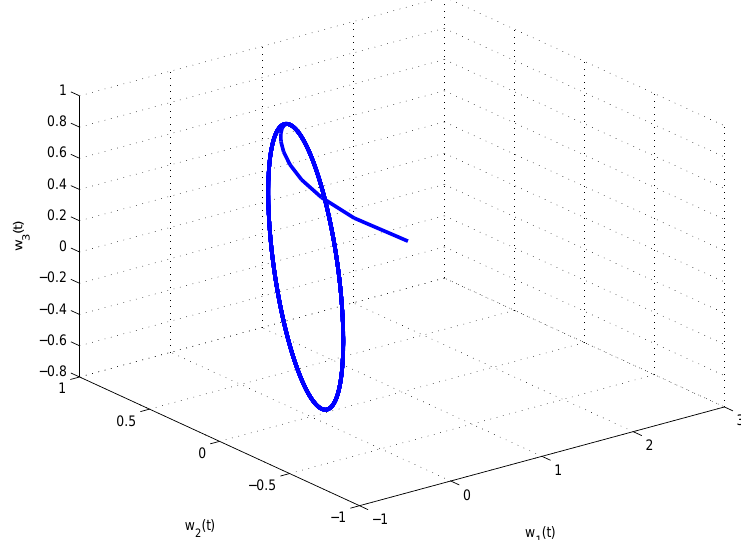
Figure 4. The phase trajectories of w 1 ( t ) , w 2 ( t ) and w 3 ( t ) of system (70) for the external inputs